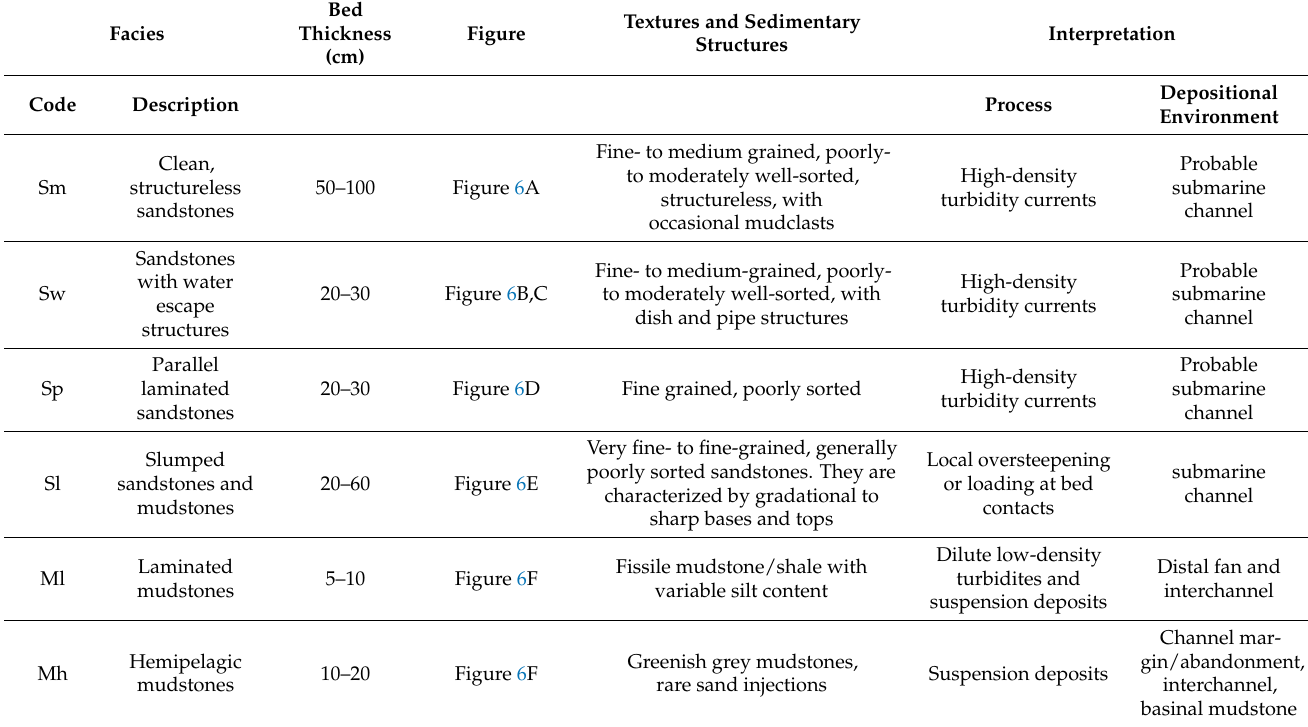
Channel mar- gin/abandonment, interchan- nel, basinal mudstone